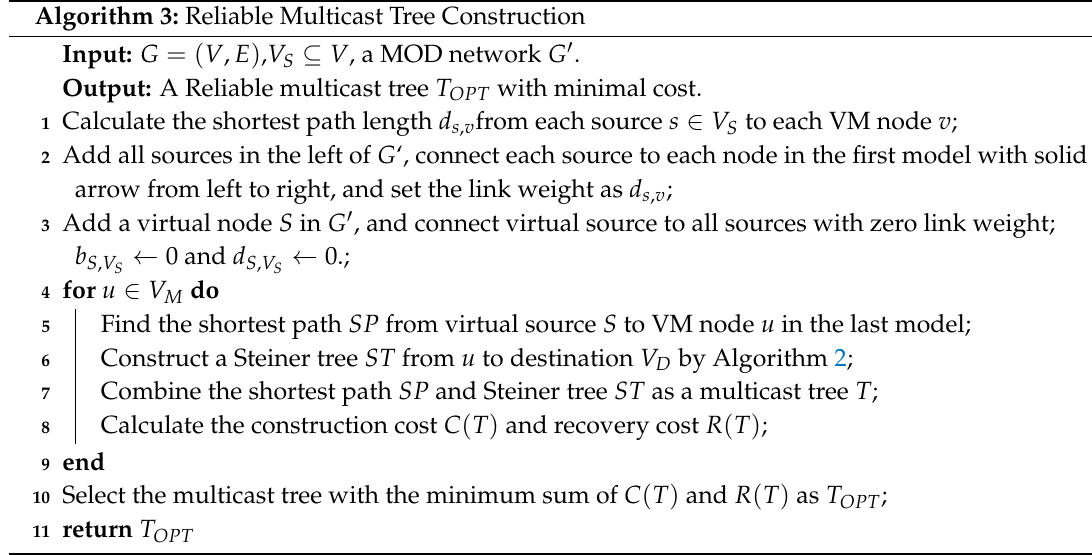
Algorithm 3: Reliable Multicast Tree